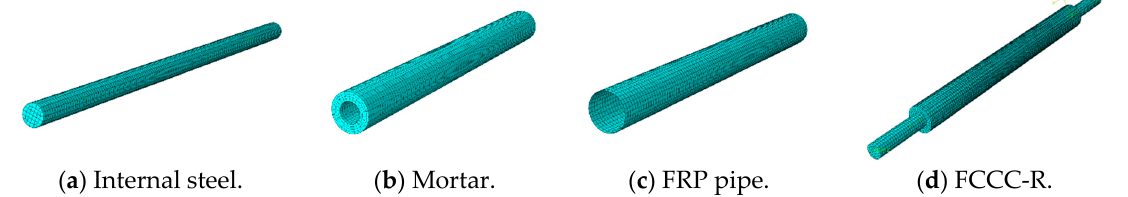
Figure 7. Configuration of FCCC-R model.